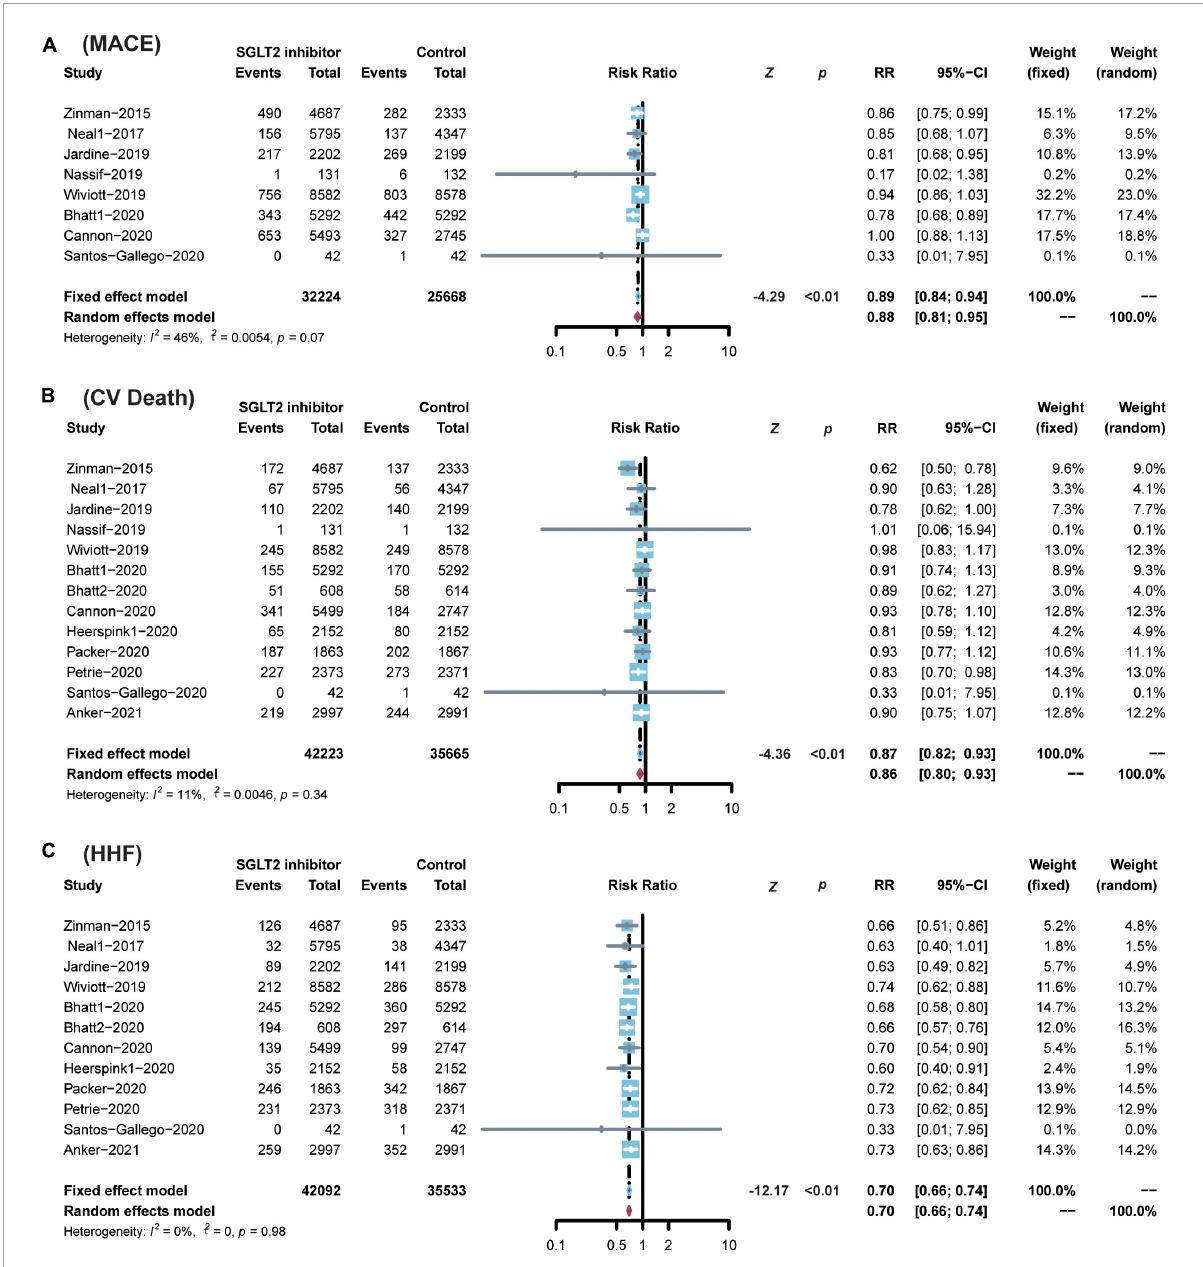
FIGURE4 Comparison of SGLT2 inhibitor vs. control group on the risks of (A) MACE; (B) CV death; (C) HHF. SGLT2, Sodium-glucose cotransporter 2; MACEs, major adverse cardiac events; CV death, cardiovascular death; HHF, hospitalization for heart failure.